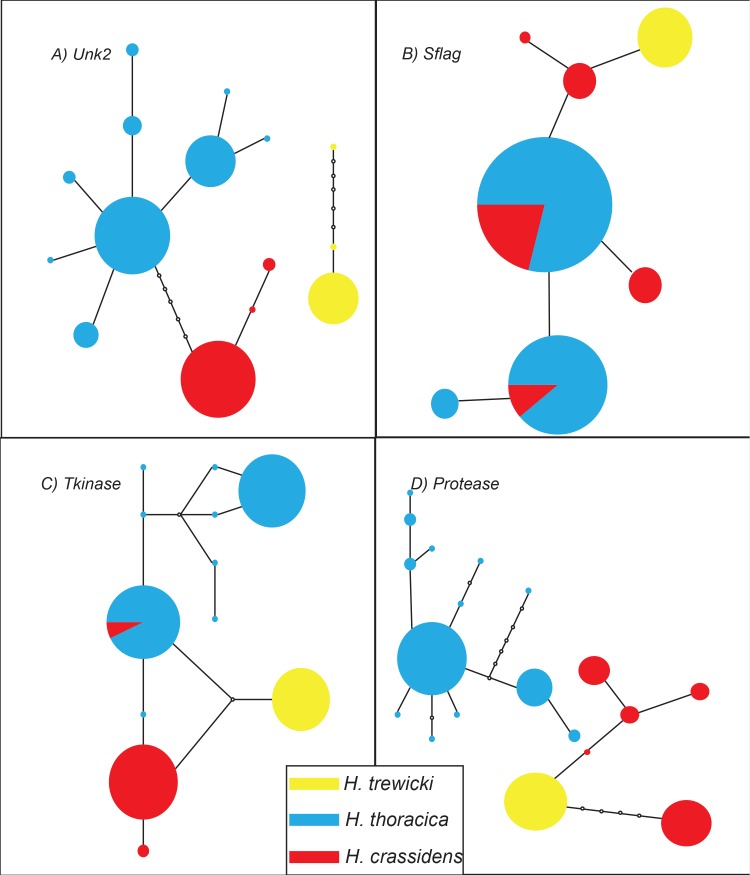
Haplotype network of A) Unk2, B) Sflag, C) Tkinase, and D) Protease gene regions. Circles represent different haplotypes, with the circles area being proportional to the frequency of each haplotype. Lines between haplotypes represent mutational steps between sequences. The empty circles represent inferred unsampled haplotypes. Colours correspond to species: Red, H. crassidens; Blue, H. thoracica; Yellow, H. trewicki.